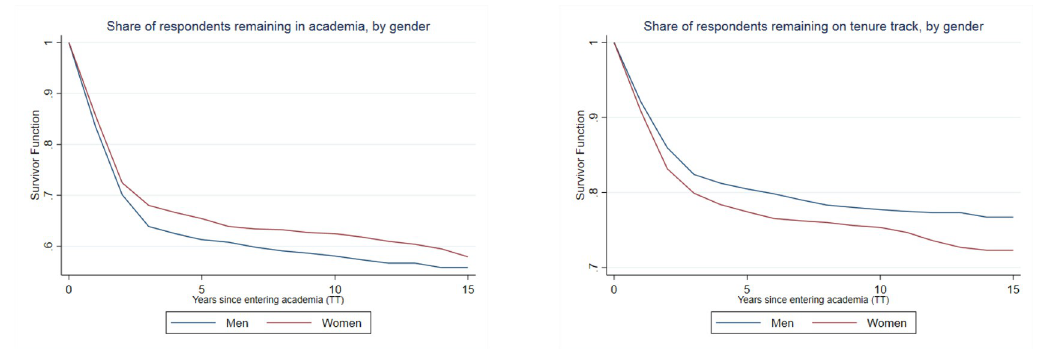
Fig 1. Persistence of men and women remaining in academia and remaining on the tenure track. (A) Share of respondents remaining in academia, by gender. (B) Share of respondents remaining on tenure track, by gender. Notes : Survival curves showing the share of men and women who remain in academia overall (A), conditional on not having left academia in prior years; and the share of men and women who remain on the tenure track (B), conditional on not having left the academic tenure track in prior years. Time measured relative to the point when individuals enter the academia. Analyses based on data from the National Survey of Earned Doctorates and National Survey of Doctoral Recipients.